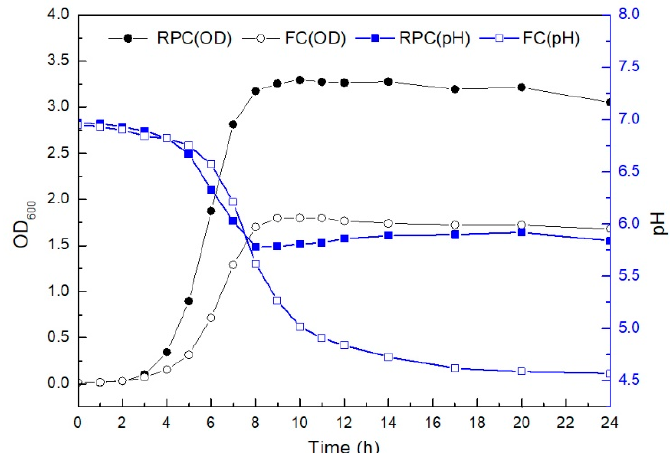
Figure 1. The differences in OD 600 and pH for E. faecalis LD33 cultured under fermentative and respiration-permissive conditions respectively during the whole growth period (24 h), respectively. RPC and FC mean E. faecalis LD33 cultured under respiration-permissive and fermentation conditions, respectively.